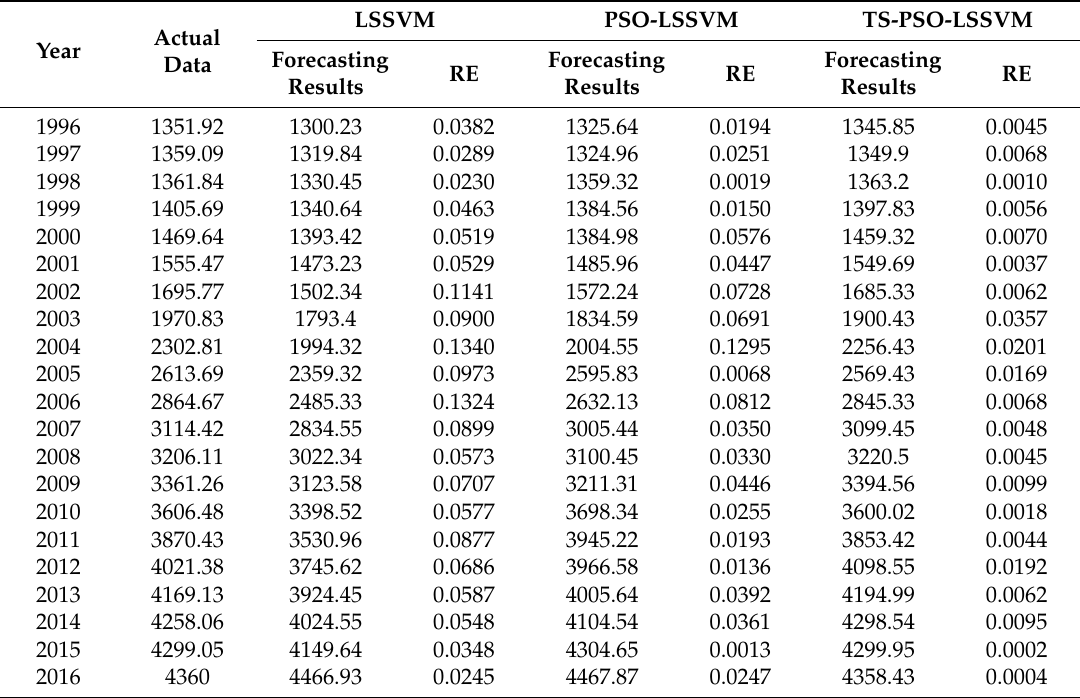
Table 5. Correlation error (RE) of three forecasting results.